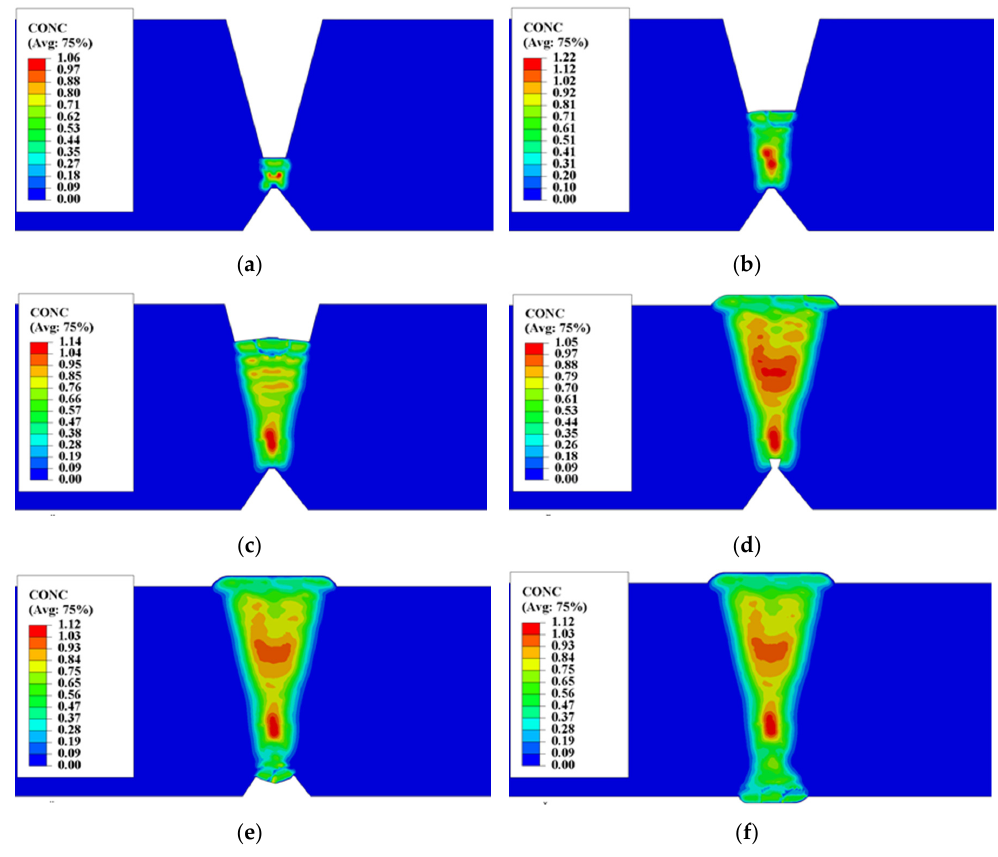
Figure 11. Distribution characteristics of hydrogen concentration (CONC) during welding of heavy plate: ( a ) 3rd weld pass front; ( b ) 11th weld pass front; ( c ) 23rd weld pass front; ( d ) Cosmetic bead front; ( e ) 6th weld pass back; ( f ) Cosmetic bead back.